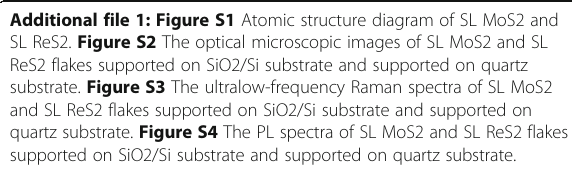
Additional file 1: Figure S1 Atomic structure diagram of SL MoS2 and SL ReS2. Figure S2 The optical microscopic images of SL MoS2 and SL ReS2 flakes supported on SiO2/Si substrate and supported on quartz substrate. Figure S3 The ultralow-frequency Raman spectra of SL MoS2 and SL ReS2 flakes supported on SiO2/Si substrate and supported on quartz substrate. Figure S4 The PL spectra of SL MoS2 and SL ReS2 flakes supported on SiO2/Si substrate and supported on quartz